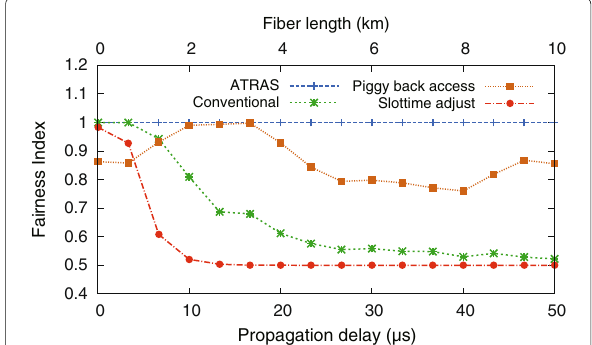
Fig. 13 Fairness Index when the RoF AP used each